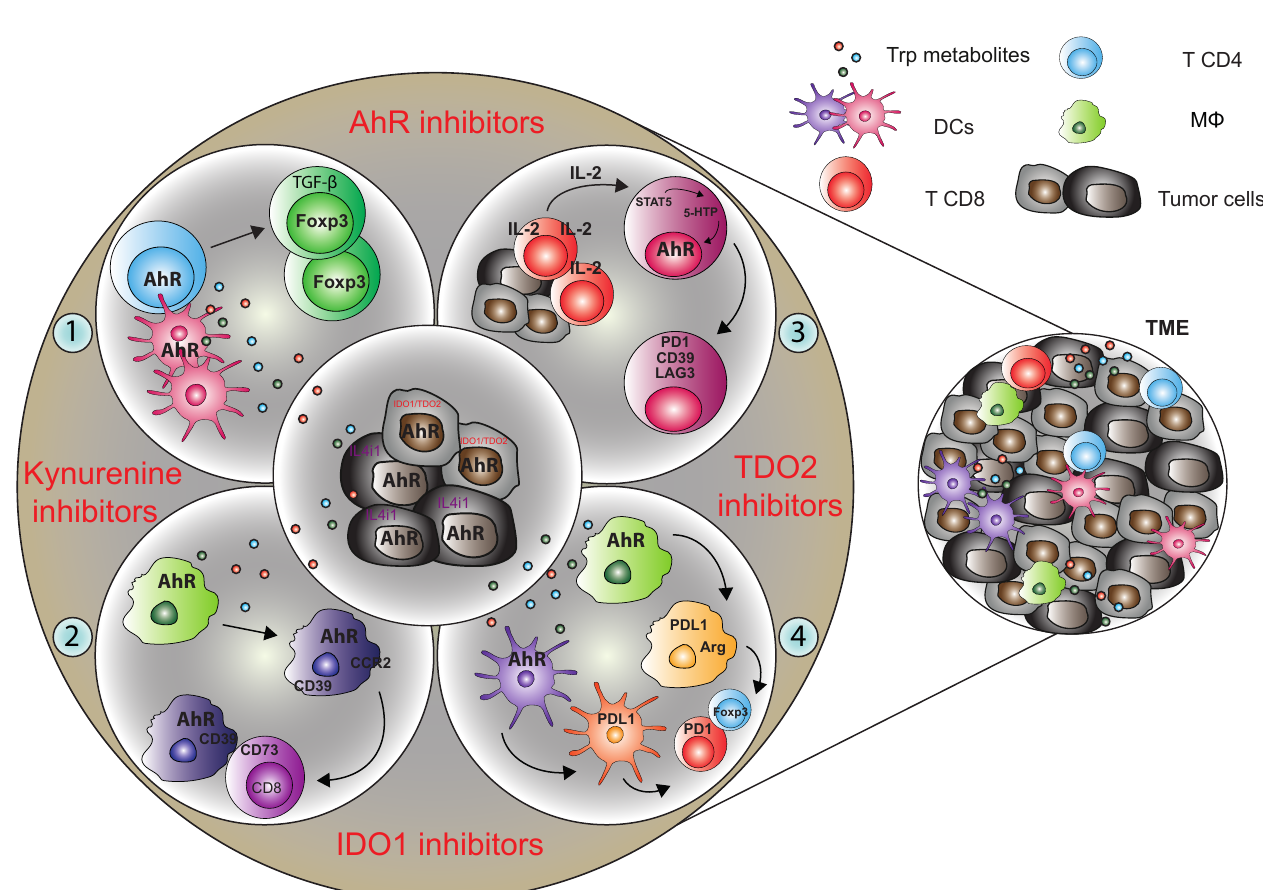
Figure 4. Targeting of tryptophan metabolic pathways for cancer therapy. Tryptophan-derived metabolites are immunosup- pressive within the TME and directly affect T and other immune cell functions. (1) Kynurenine derived by IDO1/TDO2 competent tumor cells can affect the T cell function promoting directly or through the tolerogenic dendritic cells the regulatory T cells differentiation. (2) Moreover, kynurenine produced by glioblastoma cells activates AhR in TAMs to modulate their function and T cell immunity. AhR promotes CCR2 and CD39 expression in TAMs thus leading to CD8 + T cell dysfunction by producing adenosine in cooperation with CD73. (3) Molecules, such as cytokines, produced by host’s immune cells can activate AhR promoting the T cell exhaustion. In particular, high level of IL-2 leads to the persistent activation of STAT5 in CD8 + T cells, which in turn induces strong expression of tryptophan hydroxylase 1, thus catalyzing the conversion to tryptophan to 5-HTP. 5-HTP subsequently activates AhR nuclear translocation, causing a coordinated upregulation of inhibitory receptors and downregulation of cytokine and effector-molecule production, thereby rendering T cells dysfunctional in the tumor microenvironment. (4) In addition, IDO-Kyn-AhR-mediated immunosuppression depends on an interplay between Tregs and tumor-associated macrophages, which can be reversed by AhR inhibition. In the outer part of the circle, proposed targeting startegies able to inhibit the activity of the tryptophan metabolites are indicated in